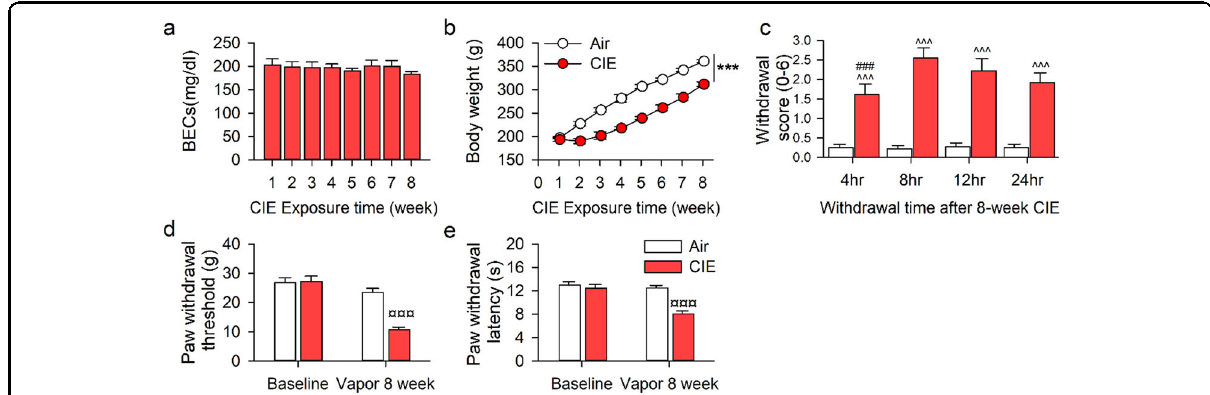
Fig. 1 Pain hypersensitivity in rats withdrawing from chronic intermittent ethanol vapor exposure. Adult male Long-Evans rats were intermittently and randomly exposed to ethanol vapor (CIE, n = 18) or Air (AIR, n = 18) for 8 weeks. a The blood ethanol concentrations (BECs) were randomly collected from 11 of 18 CIE rats and measured once per week. b The body weight of rats during 8-week CIE or Air exposure ( n = 11/group). c The physical withdrawal scores of CIE and AIR rats at 4, 8, 12, and 24 h abstinence after 8-week vapor exposure ( n = 18/group). d , e The average paw withdrawal threshold or latency of rats before and after 8-week chronic vapor exposure (CIE n = 18, AIR n = 15). All data are expressed as mean ± SEM. *** p < 0.001, ^^^ p < 0.001, ¤¤¤ p < 0.001 vs. Air grou p , ### p < 0.001 vs 8 – 24 h withdrawal time within CIE group by two-way RM